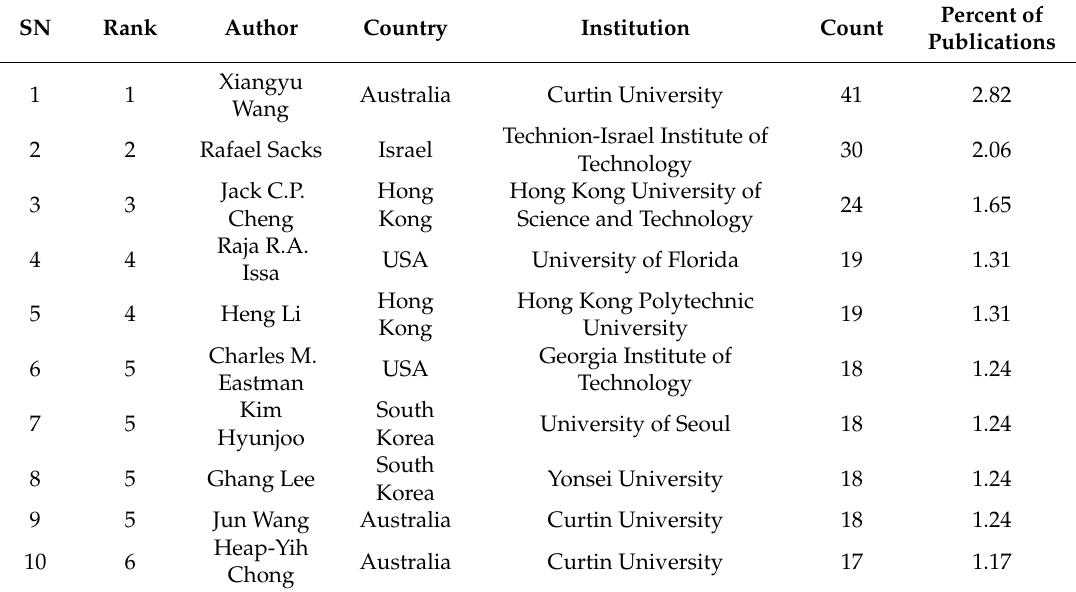
Table 2. Top 10 productive BIM article